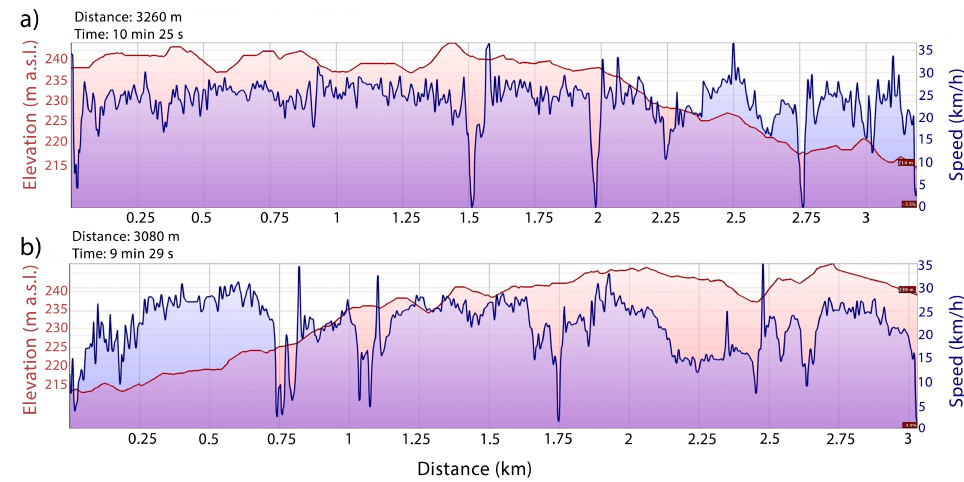
Figure 2. Elevation (red) and speed (blue) graphs for the existing main ( a ) and alternative ( b ) cycling route [25]. Note the opposite cycling direction, marked by the opposite elevation gradient.